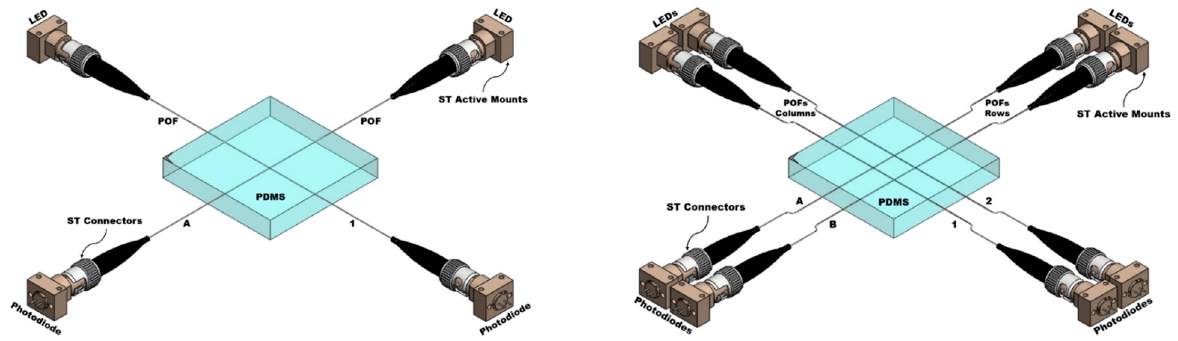
Figure 2. Three-dimensional models of the 1 POF × 1 POF and 2 POFs × 2 POFs sensor pads with the light sources (LEDs) and photodiodes coupled to each fiber.